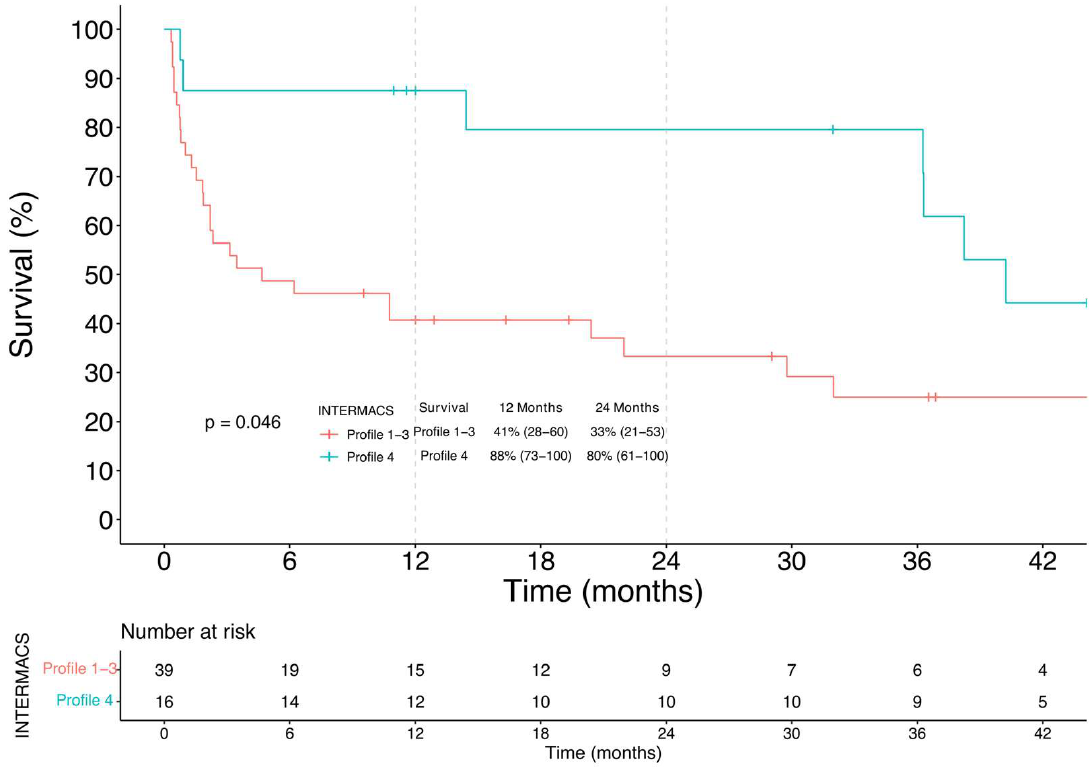
Figure 6. Kaplan–Meier analysis of survival among INTERMACS Profile 1–3 and Profile 4 BTC patients.